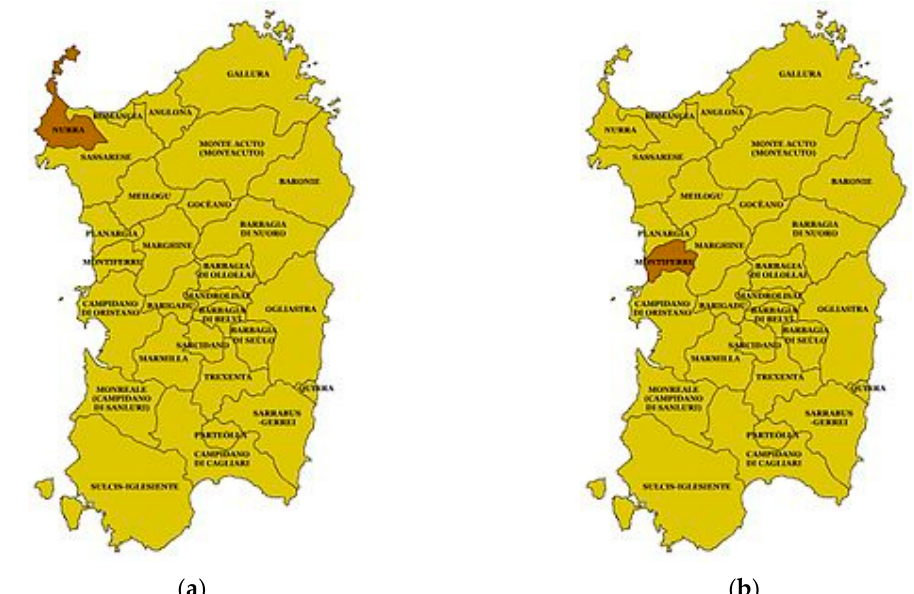
Figure 1. Geographical collocation of Nurra ( a ) and Montiferru ( b ) in Sardinia (maps by Wikipedia ).